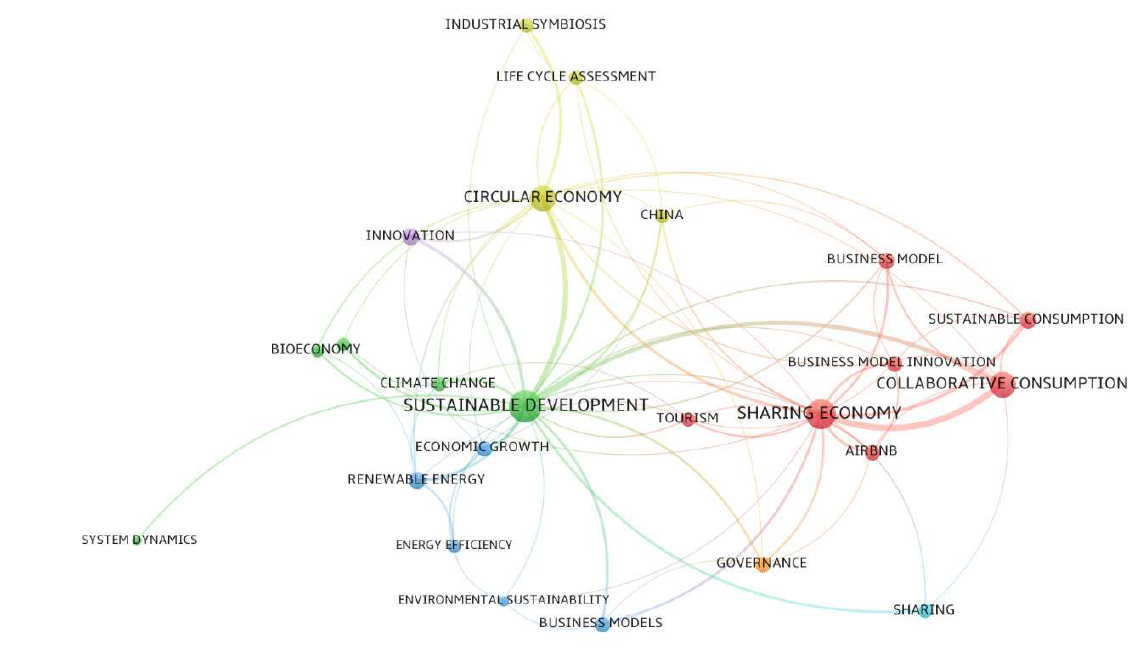
Figure 8. Co-occurrence map of the high-frequency keywords of the retrieved documents